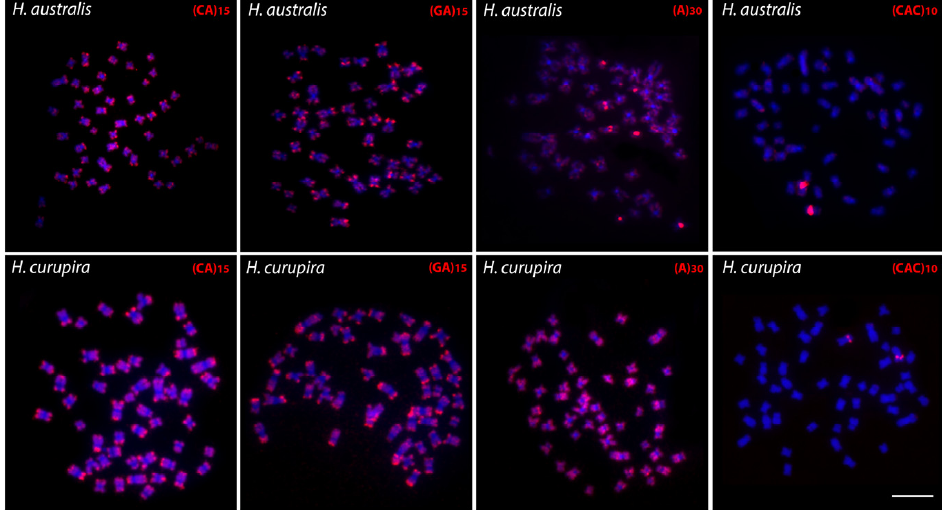
Figure 3. Microsatellite sequences (red) mapped against chromosomes of Hoplias australis and H. curupira . Chromosomes were counterstained with DAPI (blue). Scale bar = 5 µ